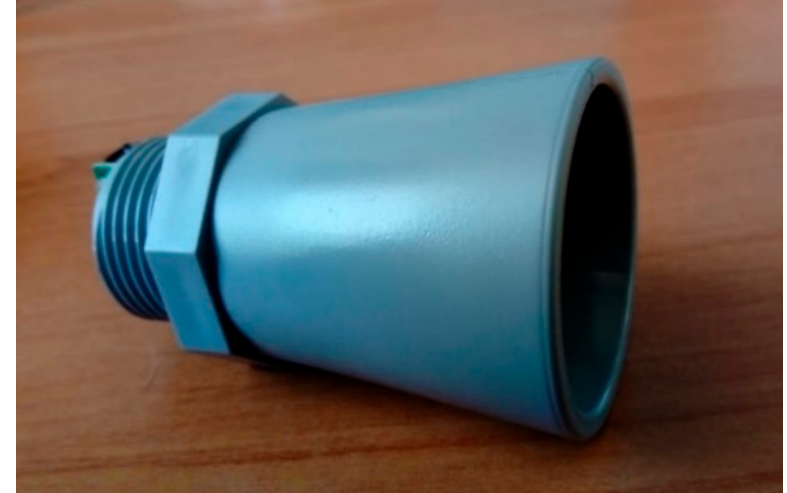
Figure 3. Ultrasonic sensor MaxSonar MB7066.